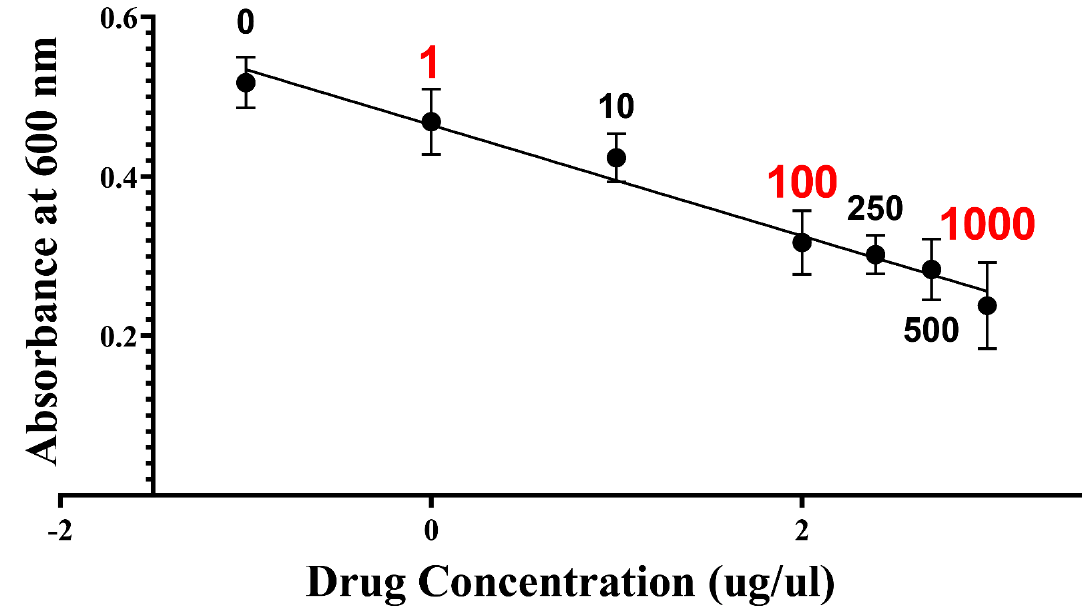
Figure 1. Selection of optimal loading concentration (IC50). Dependency of IC 50 and TCS concentration used in selecting optimal concentration. The x axis was log transformed. Seven different concentrations were tested. Three samples with concentrations labeled red were selected for proteomic analysis. Samples with 1, 10, and 1000 µg/µL added are mentioned in the following context as samples A, B, and C, respectively.